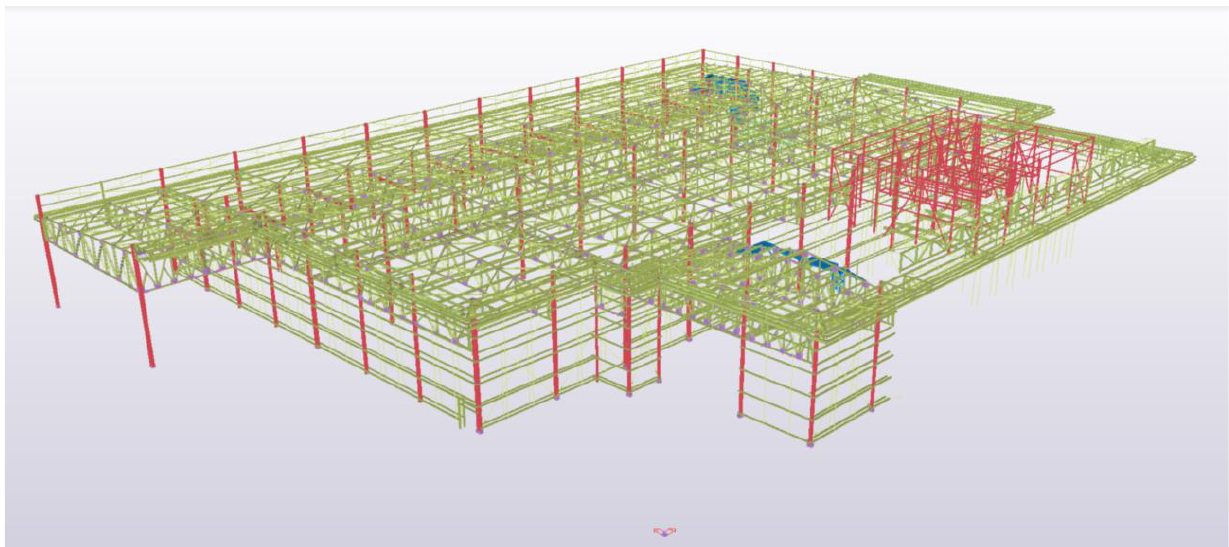
Figure 13. Tekla Model — Study sample.